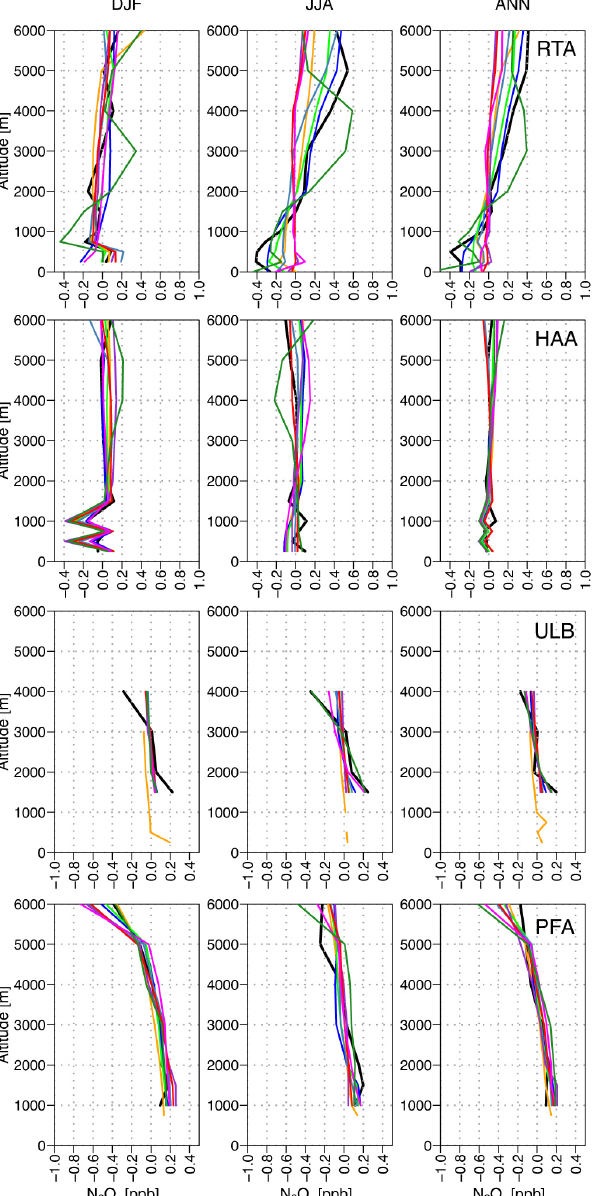
Fig. 4. Vertical profiles of N 2 O (ppb) at RTA, HAA, ULB and PFA (from top to bottom). The mean tropospheric mixing ratio at each site has been subtracted from the vertical profile. DJF=December, January, February; JJA=June, July, August; ANN=annual. Leg- end: Mozart4, yellow; ACTMt42l32, blue; ACTMt42l67, green; TM5, grey-blue; TM3-NCEP, purple; TM3-ERA, red; LMDZ4, ma- genta; TOMCAT, dark green; observed,